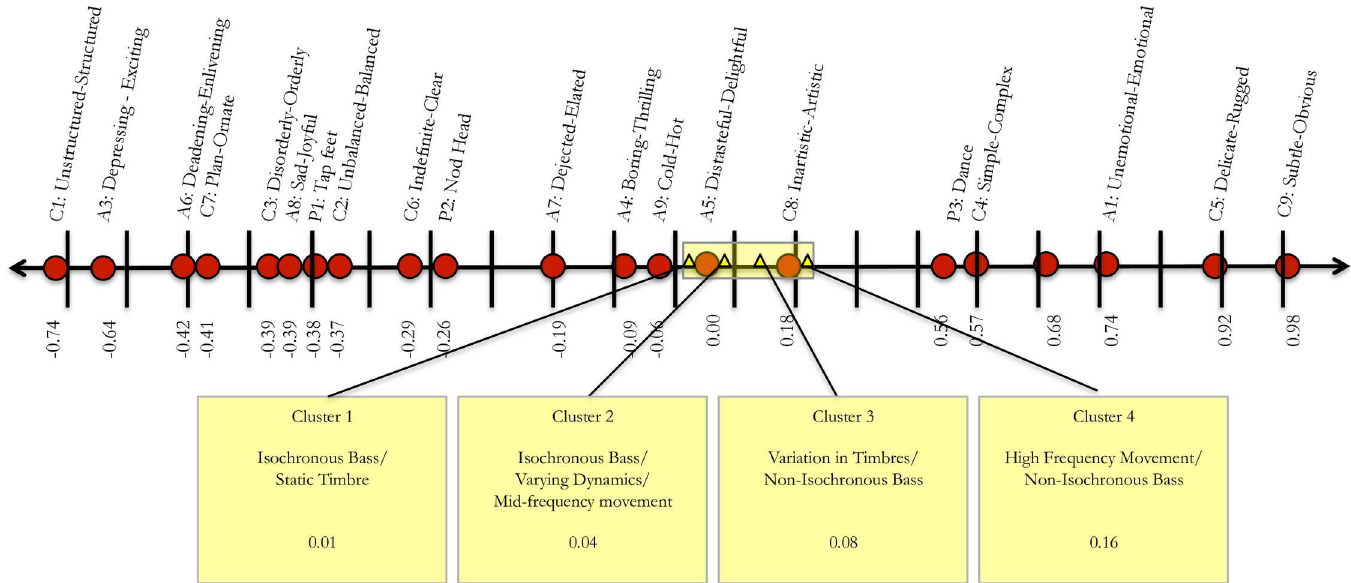
Fig 3. Visual depiction of the cluster calibration in relation to item calibration on the logit scale. (A) Cluster spread ranged from 0.01 logits to 0.16 logits and demonstrated significant distinction accordingto one fit item: Inartistic/Artistic